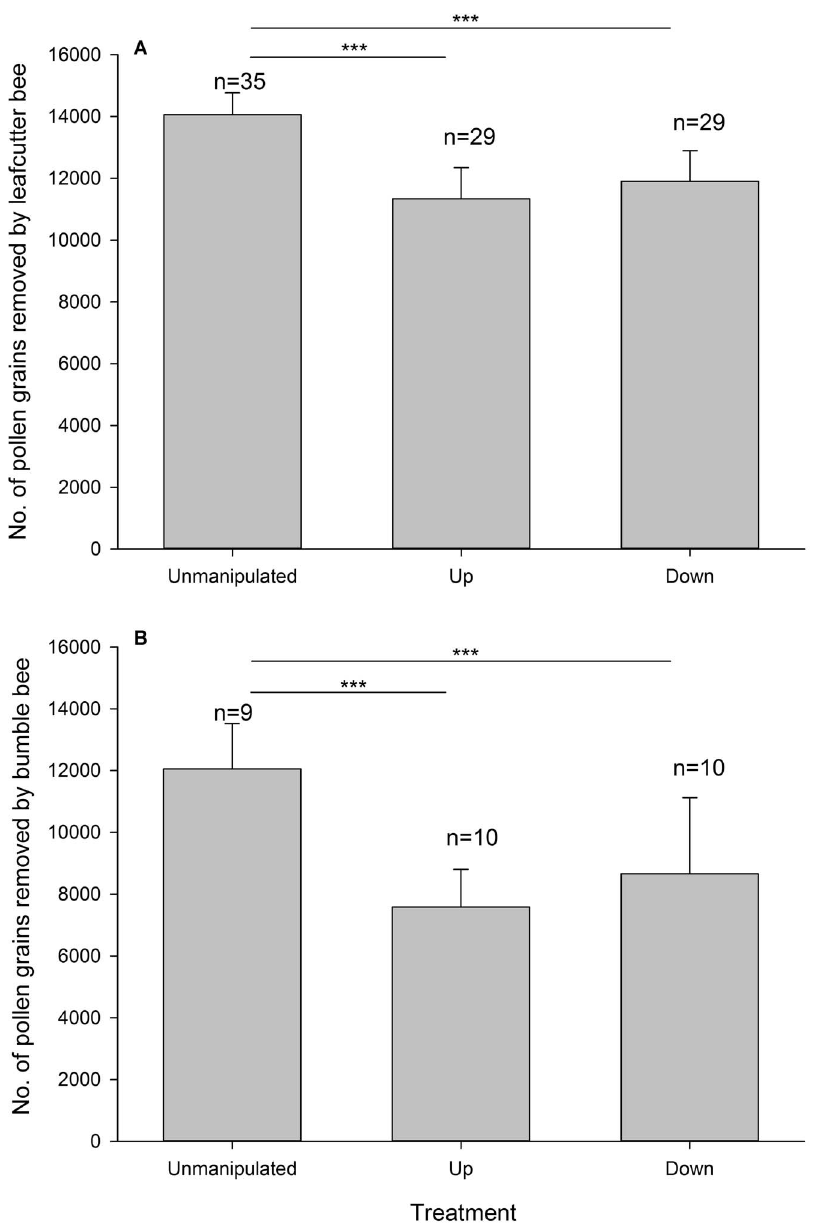
Figure 2. Comparisons in number of pollen grains removed after a single visit per flower by leafcutter bees (A) and bumble bees (B) among unmanipulated, UP, and DOWN inflorescences. Bars show standard errors. *** P , 0.001.